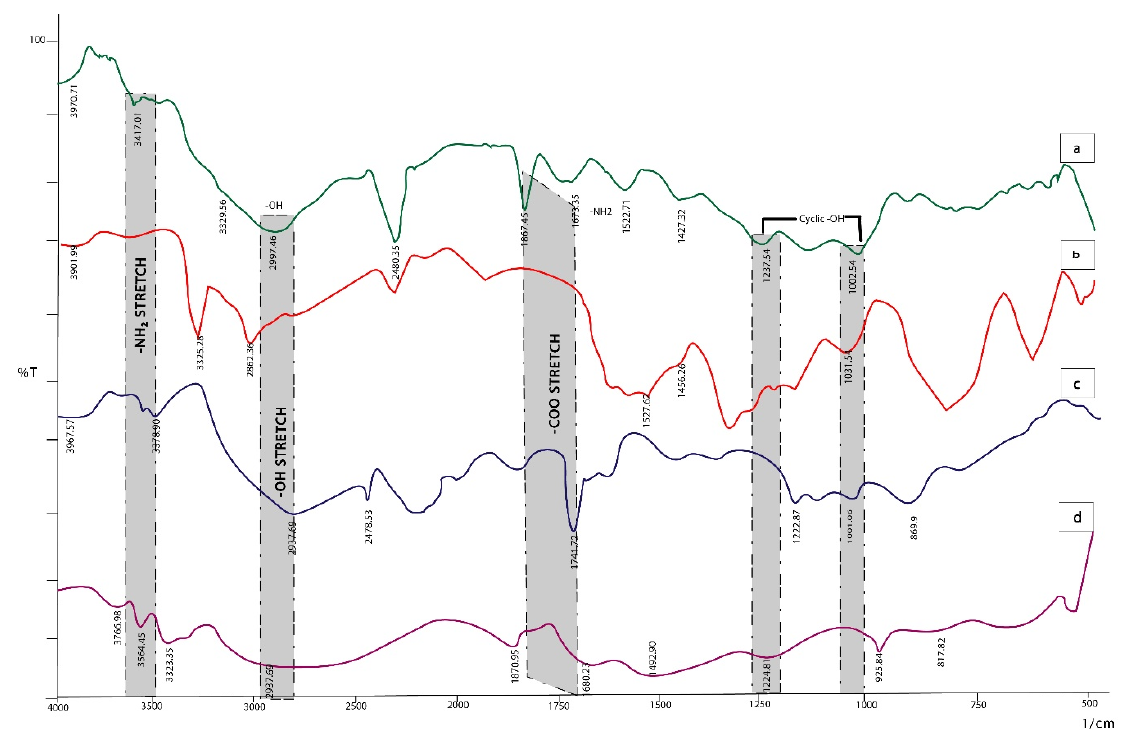
Figure 2. Drug polymer compatibility FTIR studies ( a ): MTX loaded AEM-CS NPs, ( b ): CS, ( c ): AEM and ( d ): MTX.